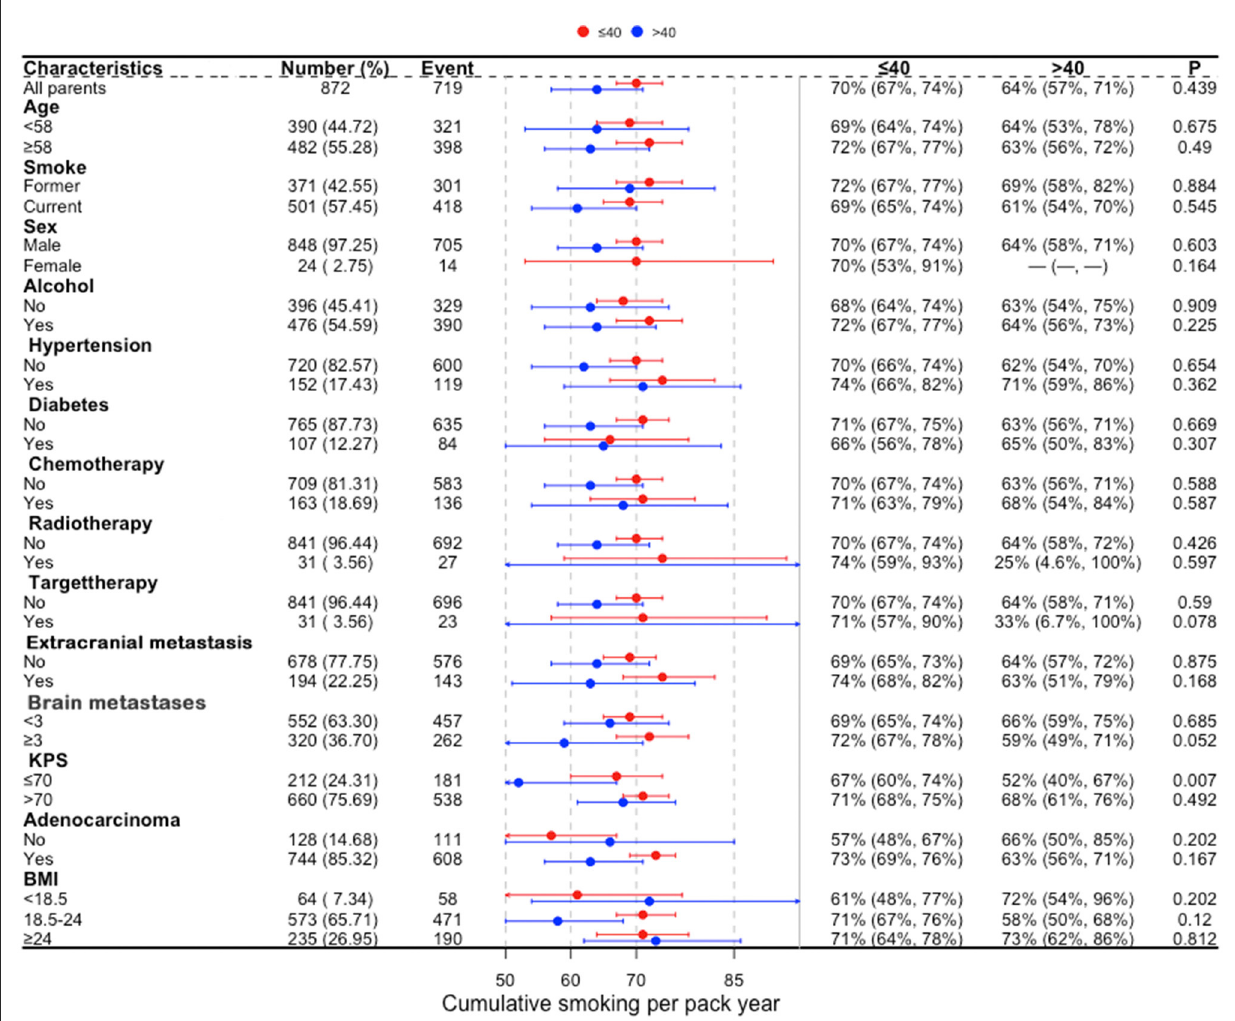
FIGURE3 Subgroup analysis of cumulative smoking in current smokers and former smokers for lung cancer patients with brain metastases. BMI, body mass index (recorded when brain metastases was diagnosed); KPS, Karnofsky performance status; Brain metastases, number of brain metastases.